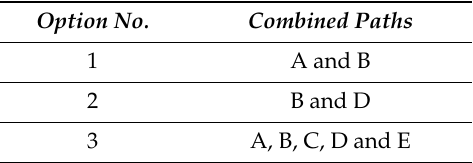
Table 1. Paths combination